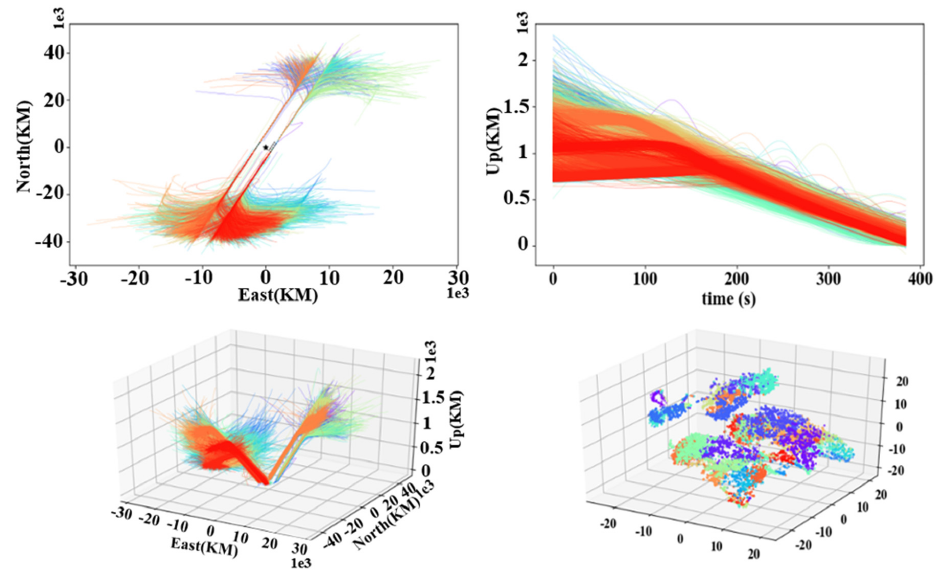
Figure 8. Visualization of clustering results of arrival trajectories.